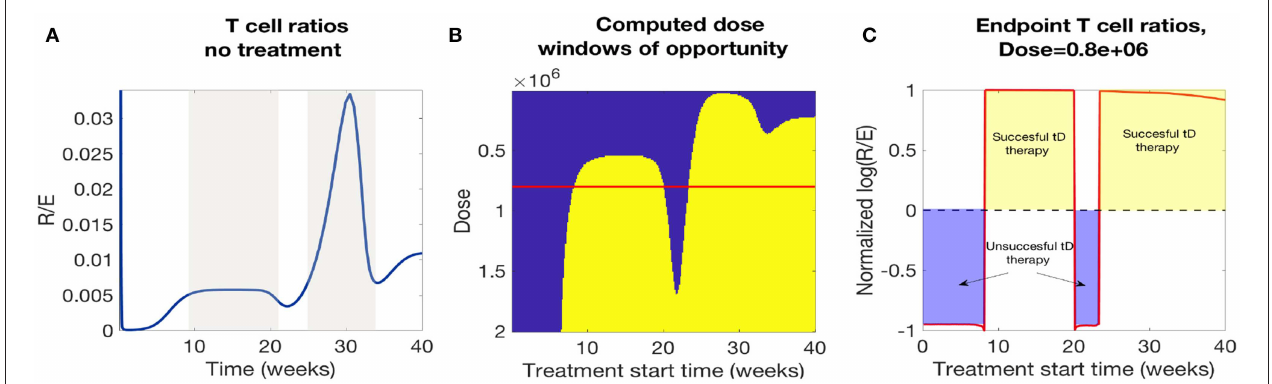
FIGURE 12 | A comparison of NOD mouse T cell ratios with computed treatment windows. (A) An untreated NOD mouse time course of the ratio of regulatory ( R ) to effector ( E ) T cells. After the apoptotic wave an increase in regulatory cells due to cell death generates a peak in the ratio ( R / E ), which qualitatively agrees with the peaks in the low dose window of opportunity calculations. (B) The NOD mouse model simulated with a single dose of tolerogenic DCs administered at a series of treatment start times. Lighter regions indicate the treatment levels that successfully return the mouse to a healthy state. Note that dose levels decrease along the y-axis, so that higher doses are in the lower part of the graph, and lower doses are in the top part. Windows of opportunity change as a function of start time and tDC injection dose. (C) Windows of opportunity (in time) for an example tDC dose level (0.8e+06), comparing outcomes for treatment started at different times. The log ratio of R / E is plotted as a function of treatment start time: log ( R / E ) > 0 indicates treatment was successful, and log ( R / E ) < 0 indicates treatment was not successful.